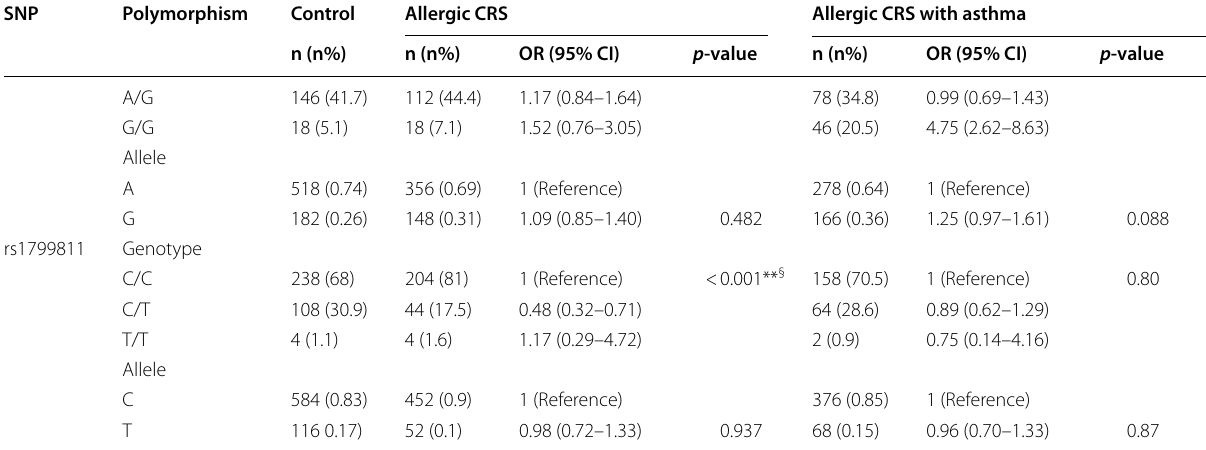
Table 4 Interaction of GSTM and GSTT genes in cases with allergic CRS, and allergic CRS with asthma and controls